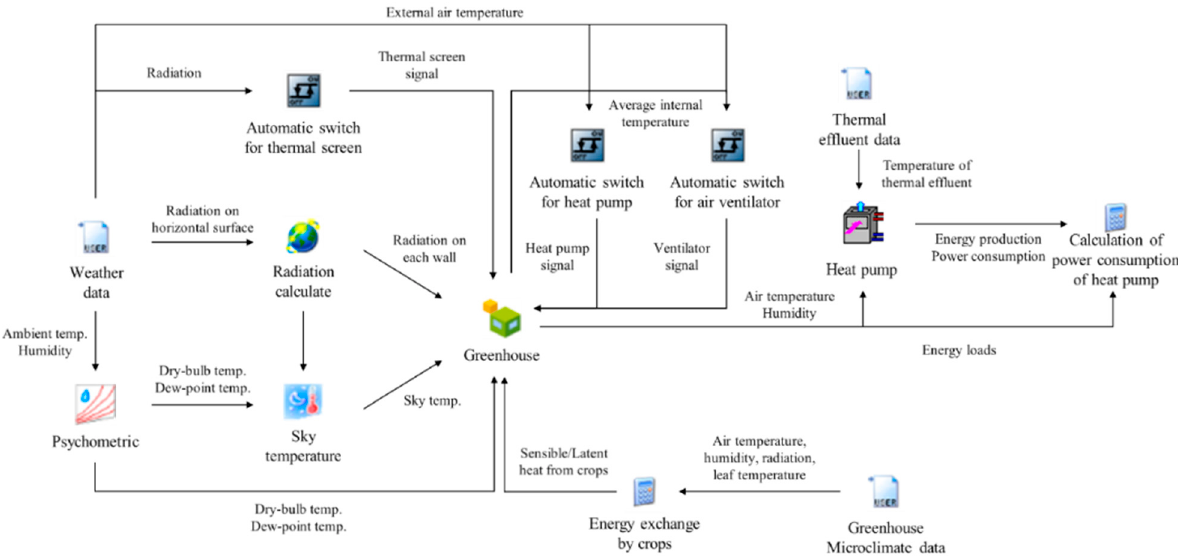
Figure 4. Design of BES model for calculating the energy loads of the greenhouse (adapted from [54]).